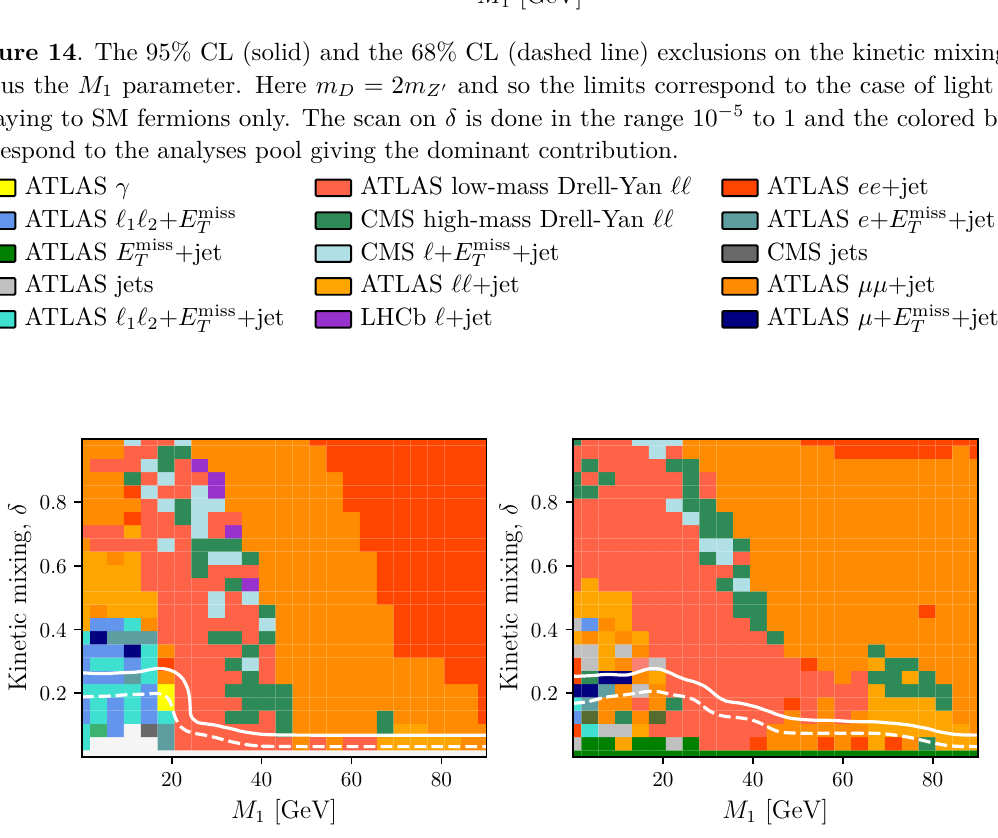
Figure 15 . The 95% CL (solid) and the 68% CL (dashed line) exclusions on the kinetic mixing δ versus the M 1 parameter for the case of light Z 0 invisible decay to DM fermions with m D = m Z 0 / 4 and for g X = 0 . 1 (left panel) and g X = 1 . 0 (right panel). The color-shading scheme specifies which SM measurement has the dominant